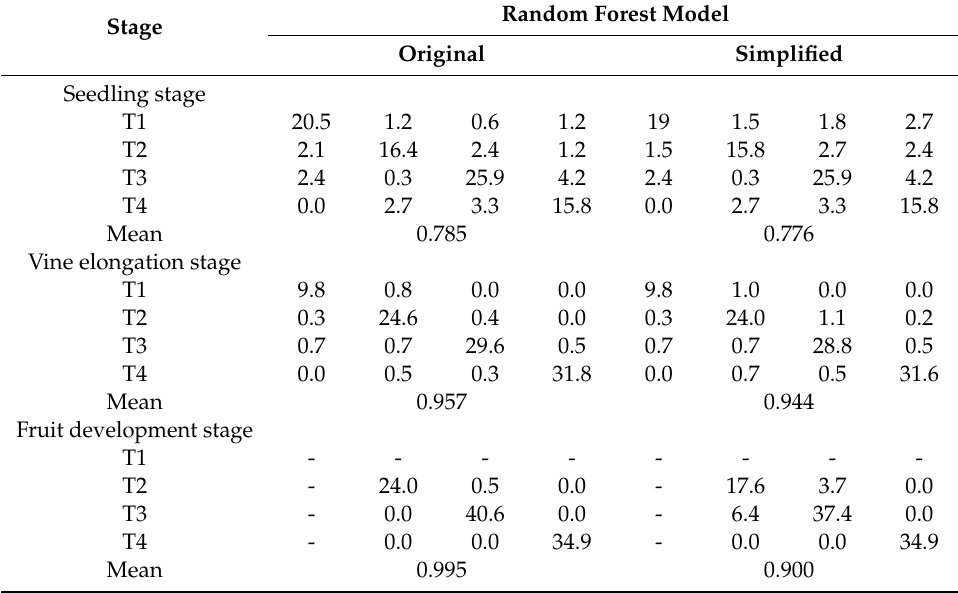
Table 3. Forecasting accuracy of substrate water content using Confusionmatrix.train function in random forest model at three growing stages of